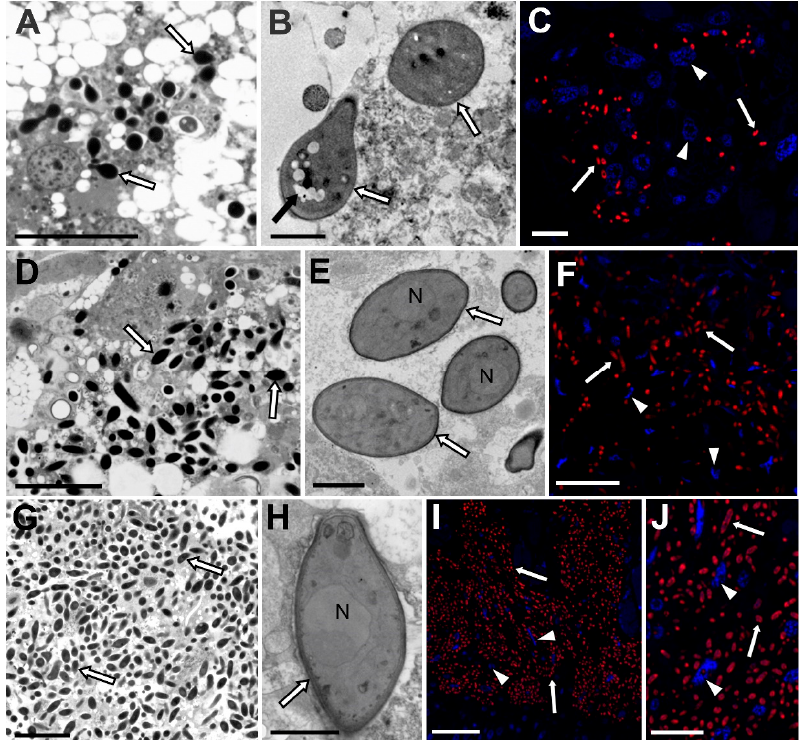
Figure 3. Distribution of symbiotic fungi in the body cavity of species examined ( A – J ). Ophiocordyceps fungi in the cytoplasm of the fat body cells ( A , D , G ). Light microscope, scale bar = 20 µ m ( B , E , H ). TEM, scale bar = 2 µ m ( C , F , I , J ). Confocal microscope, scale bar = 20 µ m ( A – C ). Eriopelitnae subfamily ( A ). Eriopeltis festucae ( B , C ). Lecanopsis formicarum ( D – F ). Coccinae subfamily ( D , E ). Parthenolecanium corni ( F ). Parthenolecanium pomeranicum ( G – J ). Filippinae subfamily, Sphaerolecanium prunastri . N—nucleus of the fungal cell; white arrow—fungal symbiont, white arrowhead—nucleus of the fat body cell, black